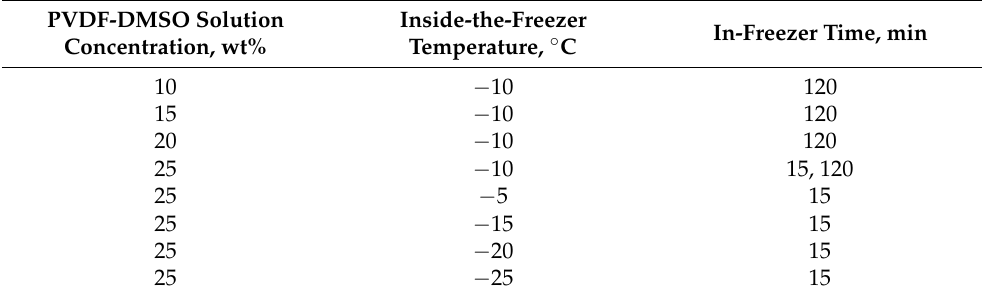
Table 1. Conditions for PVDF membranes